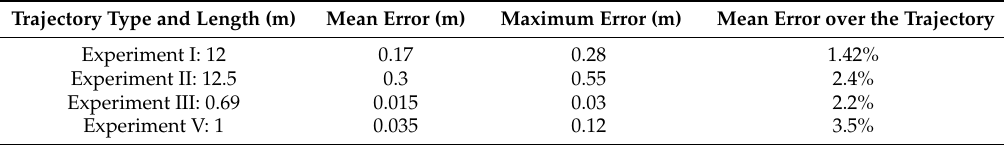
Table 3. Error accuracy analysis in four